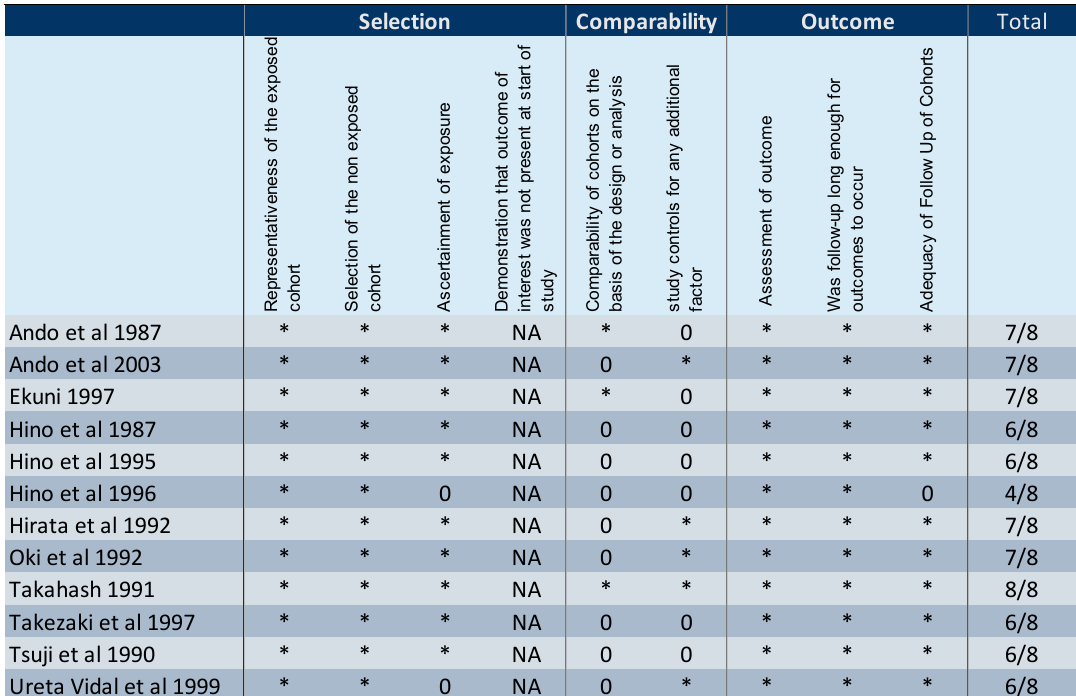
Figure 2. Forest Plot and meta-analysis showing the Risk Ratio of HTLV-1 infection in babies who were exclusive formula-fed and those who were breastfed by mothers living with HTLV-1. The boxes and lines indicate the risk ratios and their confidence intervals (CI) for each study. The pooled risk ratio is represented by a black diamond. The size of the blue squares indicates the relative weight of each estimate. Statistical analysis and graph were performed using RevMan 5 Software. Risk Ratio was calculated using Random effects model and Mantel-Haenszel statistical method [16,28,36–39,44,45,47,51,53,55].